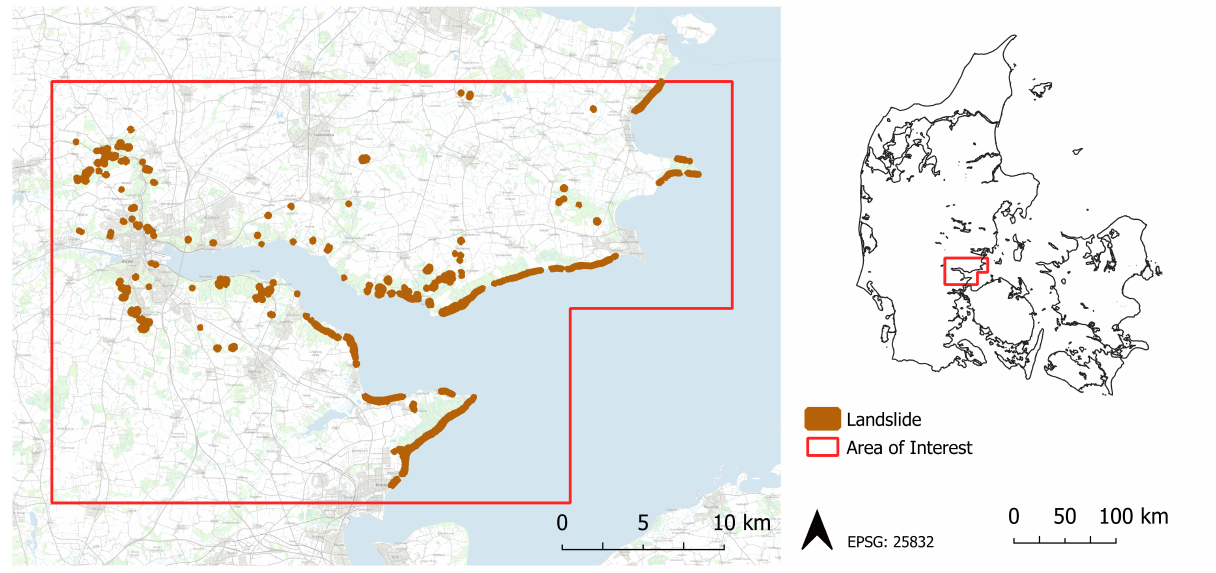
Figure 1. The selected study